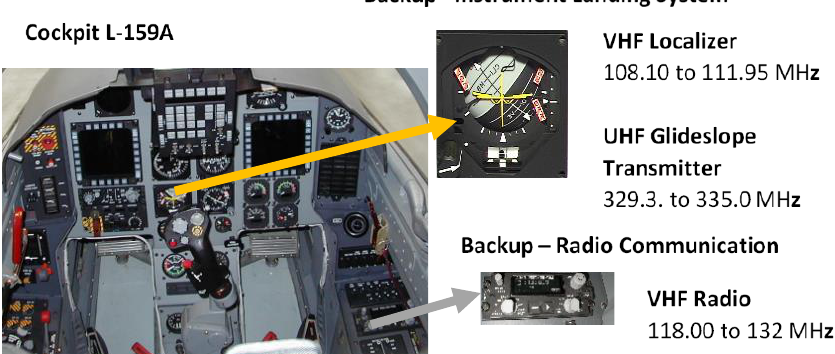
Figure 1. Very high frequency (VHF) radio systems in the cockpit of an L-159